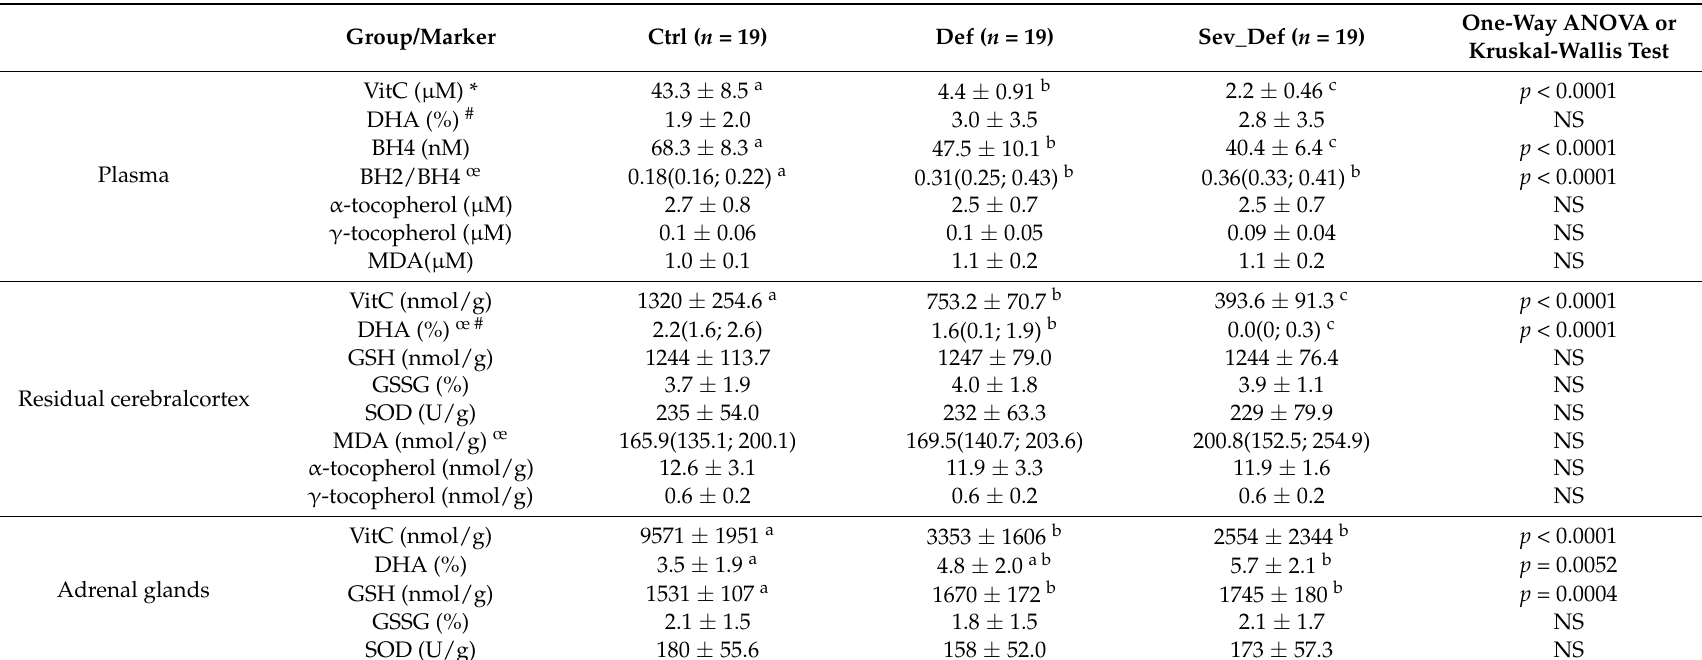
Table 2. Biochemical parameters of plasma, residual cortex and the adrenal